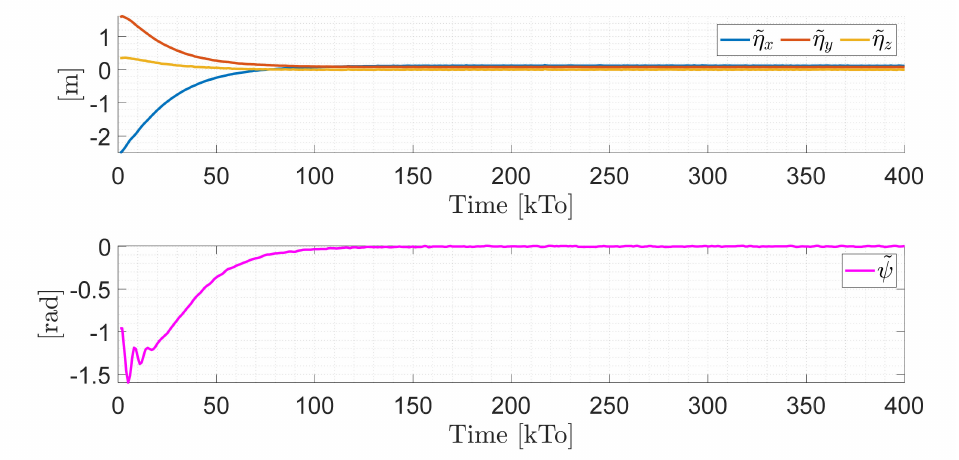
Figure 21. Time evolution of the control errors ˜ η ( kT 0 ) = ( ˜ η x , ˜ η y , ˜ η z , ˜ ψ